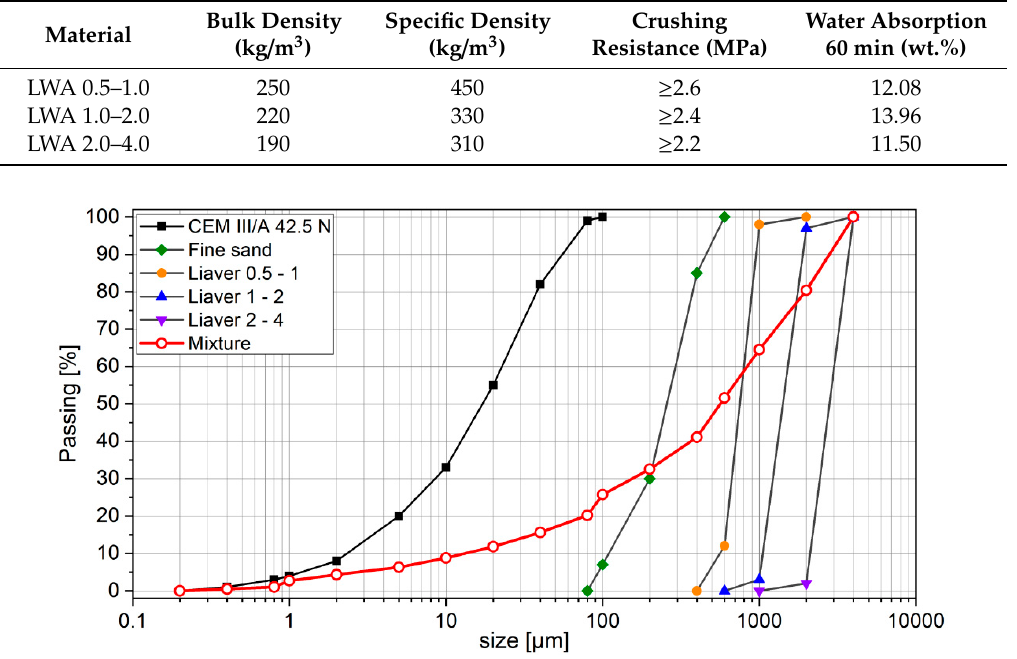
Figure 2. Particle size distributions of concrete constituents and the concrete mixture.